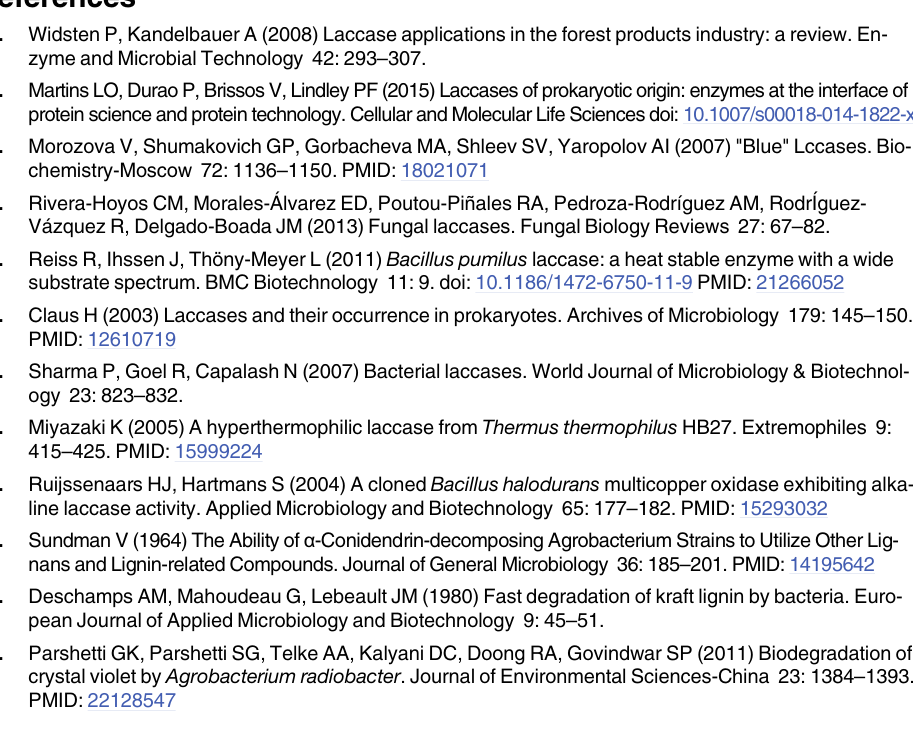
S1 Fig. Phylogenetic tree analysis of 16S gene sequences of bacteria which are closely related to strain S5-1. S2 Fig. Phylogenetic analysis of Atm and several other laccases. S1 Table. Identities (%) between Atm and several predicted laccases from Ausec et al. ’ s study